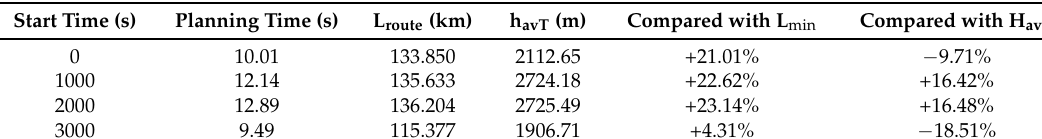
Table 8. The results of different start times under dynamic threats.